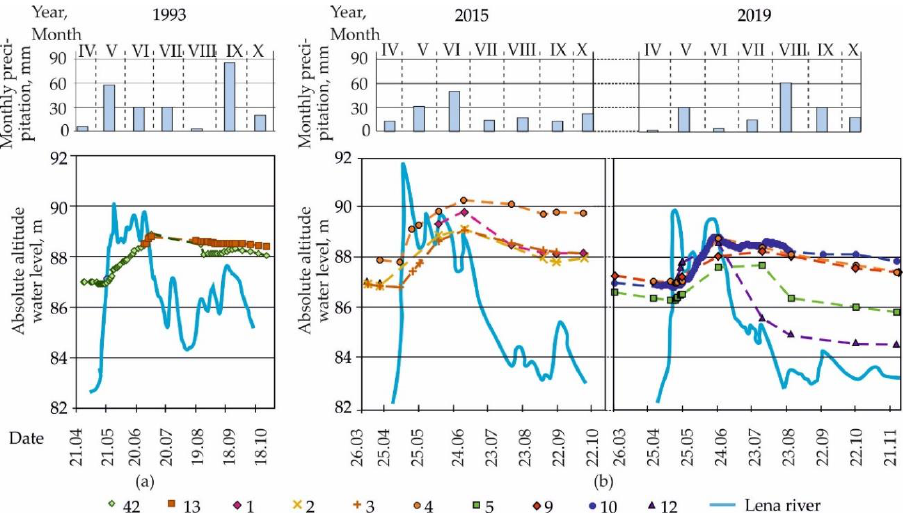
Figure 6. Variations in precipitation, Lena River water level, and groundwater level for selected years: ( a ) District 202 (based on data obtained by YakutPNIIS), and ( b ) District 203 (symbol numbers indicate borehole